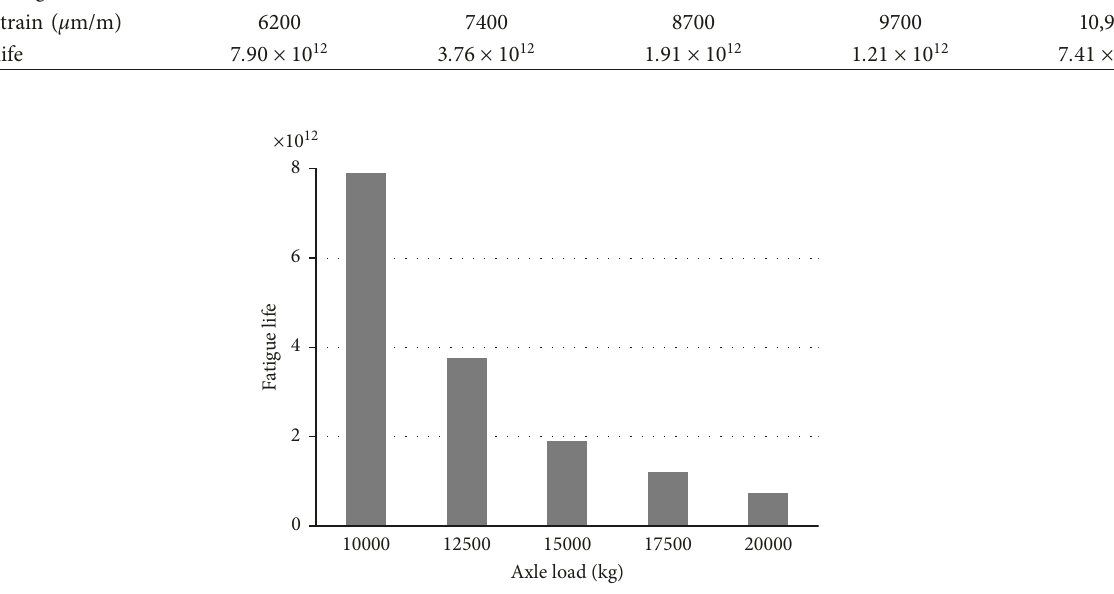
Figure 14: The fatigue life of the asphalt pavement subjected to different axle loads after loading cycles of 1 × 10 6 .